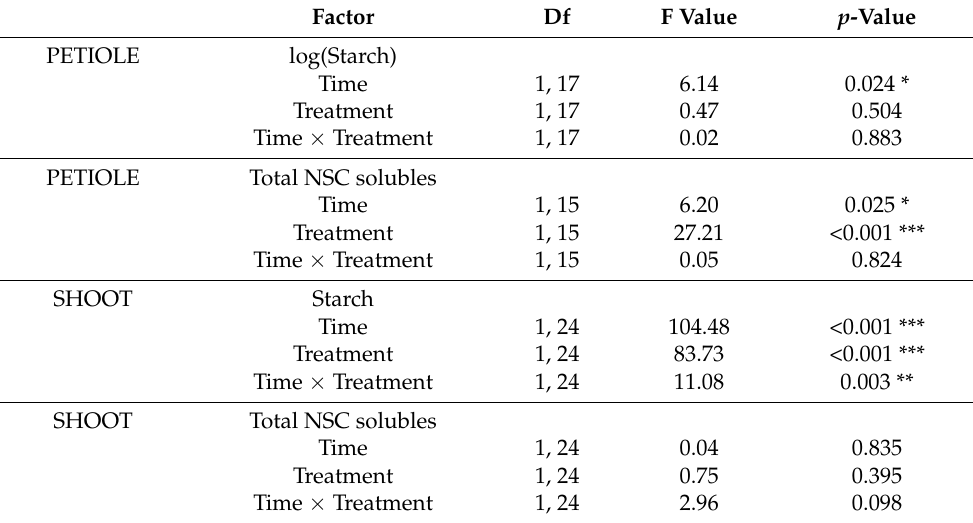
Table 2. Outcomes of the analysis of variance (two-way ANOVA) applied to starch content and total soluble NSC content in petiole, shoot and root in relation to drought stress (treatment), time and their